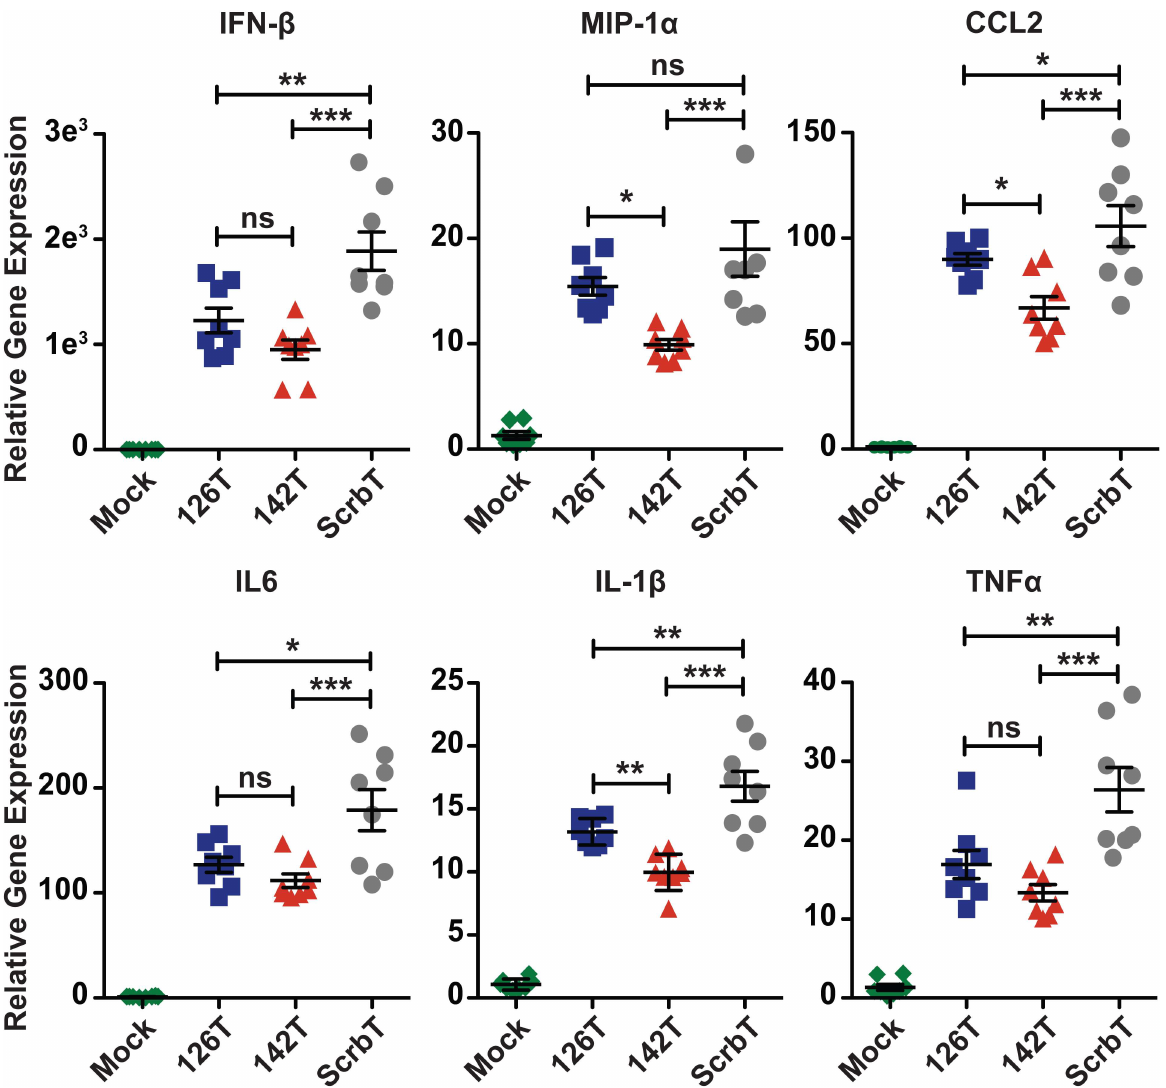
Fig 3. Restriction of cell tropism alters cytokine and chemokine responses in the lungs. C57BL/6Jmice (n = 8) were intranasally infected with a 25 PFU dose of the H5N1 viruses and total RNA from the lungs was isolated on day 5 pi via Trizol extraction. Expression levels of inflammatory genes(IFN- β , MIP-1 α , CCL2, IL-6, IL-1 β and TNF α ) were measuredby quantitativePCR analyses. Data is representedas fold expressionrelative to mock infected mice (mean ± SEM). Asterisk denotesstatistical significancedetermined by one-wayANOVA and the values are denotedas * p < 0.05, ** p < 0.01, *** p < 0.001and ns–nonsignificant.Data presentedhere is a representative of at least two independent experiments.